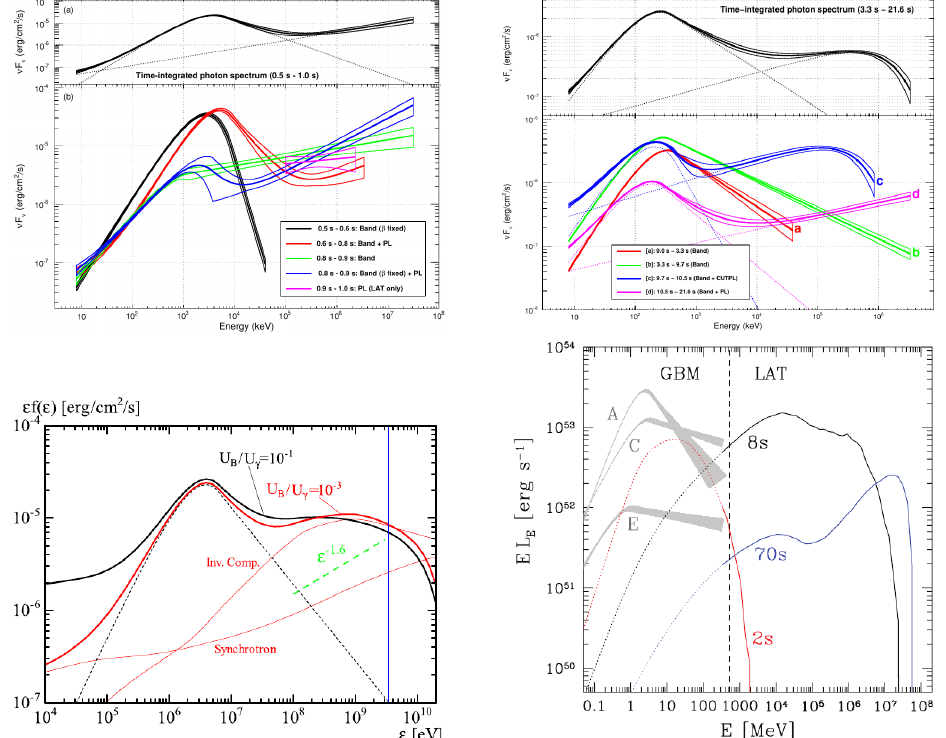
Figure 4. Top : Time-integrated and time-resolved prompt emission spectra of short-hard GRB 090510 ( left ; [108], ©AAS. Reproduced with permission.) and long-soft GRB 090926A ( right ; [109], ©AAS. Reproduced with permission.). In both cases, the spectrum shows a low- and high-energy excess which is fit by a power-law or cutoff power-law component that has a distinct origin from the main Band component. Bottom : Theoretical modeling of the spectrum of GRB 090510 using a hadronic scenario with photo-hadronic cascades ( left ; [97], ©AAS. Reproduced with permission) and that of GRB 080916C using the pre-accelerated and pair-loaded ISM in the afterglow model ( right ; [56], ©AAS. Reproduced with